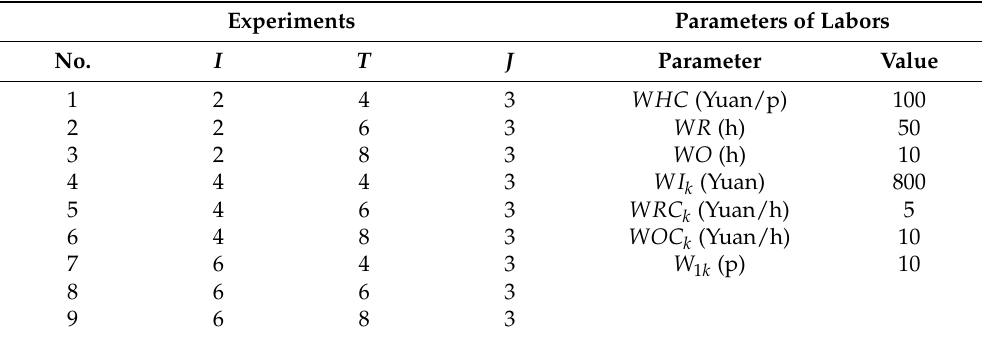
Table 6. Parameters setting.